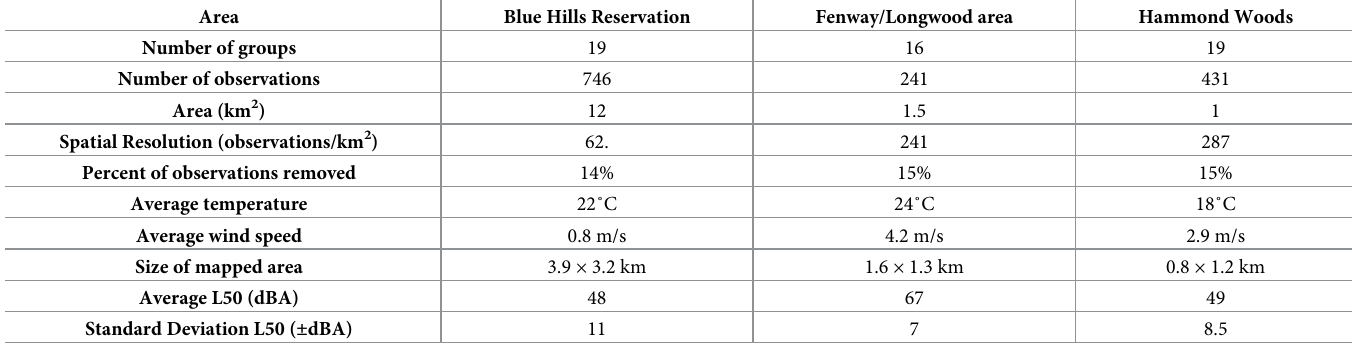
Table 1. For each citizen science event: Number of volunteer groups, total number of usable observations, the percent of data that had to be removed due to human or instrument error, and average temperature and wind speed on day of event data from the weather station at Blue Hills Observatory in Milton, MA. Area Blue Hills Reservation Fenway/Longwood area Hammond Woods Number of groups 19 16 19 Number of observations 746 241 431 Area (km 2 ) 12 1.5 1 Spatial Resolution (observations/km 2 ) 62. 241 287 Percent of observations removed 14% 15% 15% Average temperature 22˚C 24˚C 18˚C Average wind speed 0.8 m/s Size of mapped area Average L50 (dBA) 48 Standard Deviation L50 ( ±